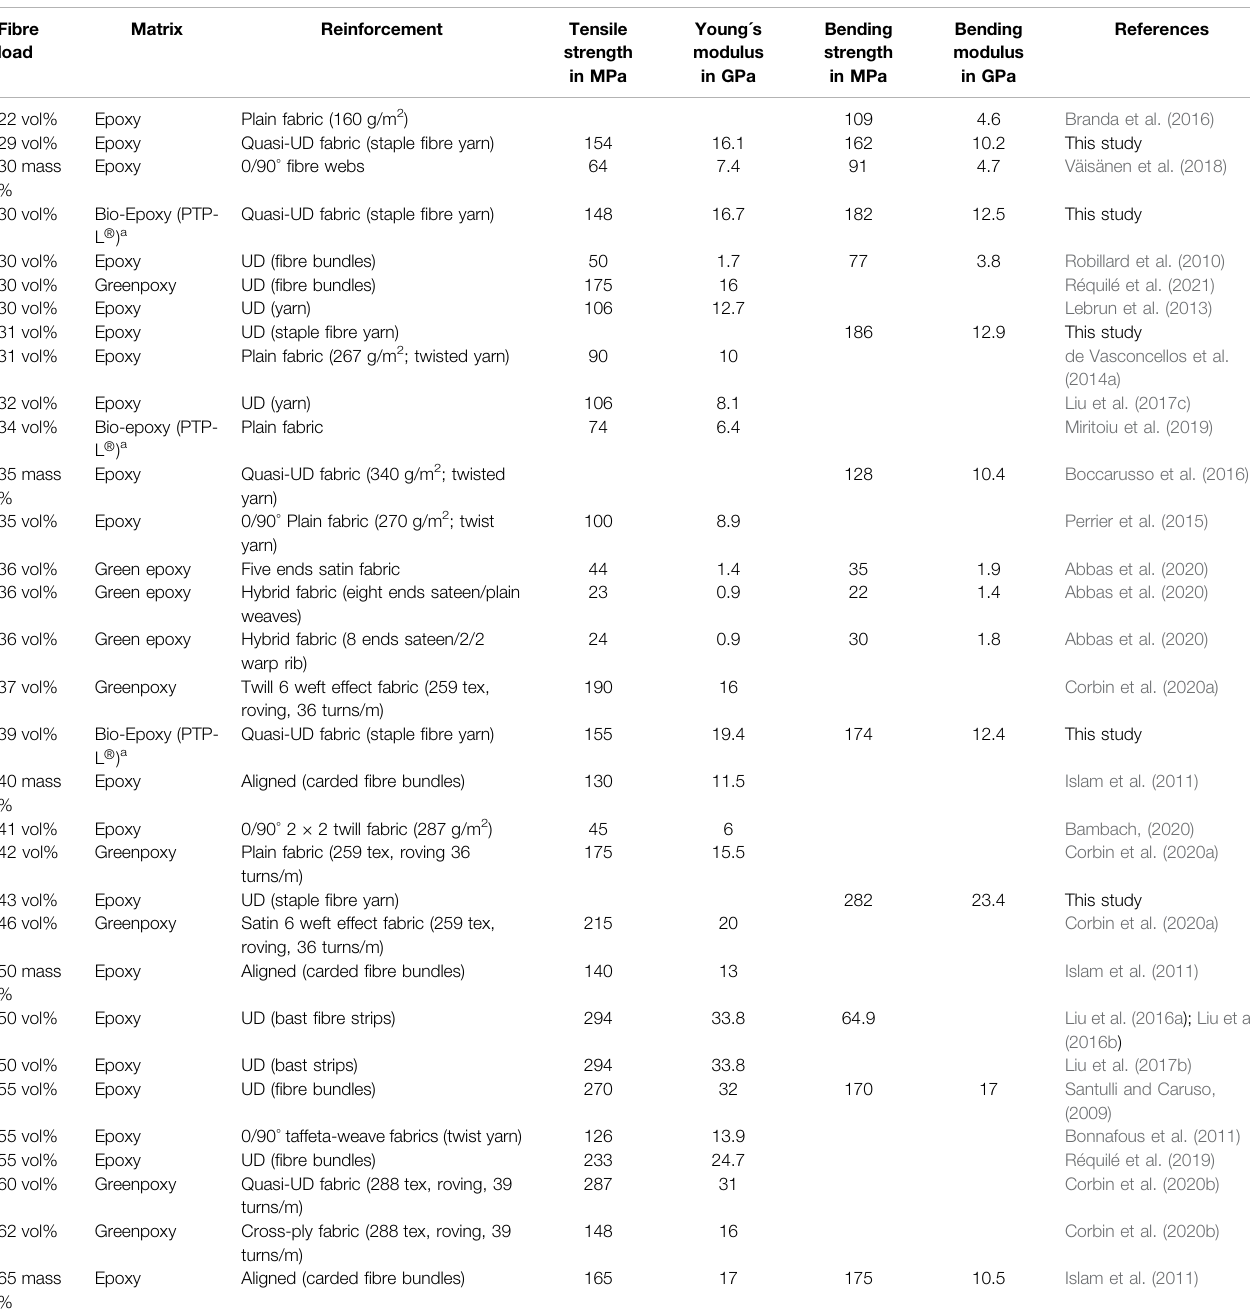
TABLE 4 | Comparison of the mechanical characteristics of hemp fi bre-reinforced composites. Fibre